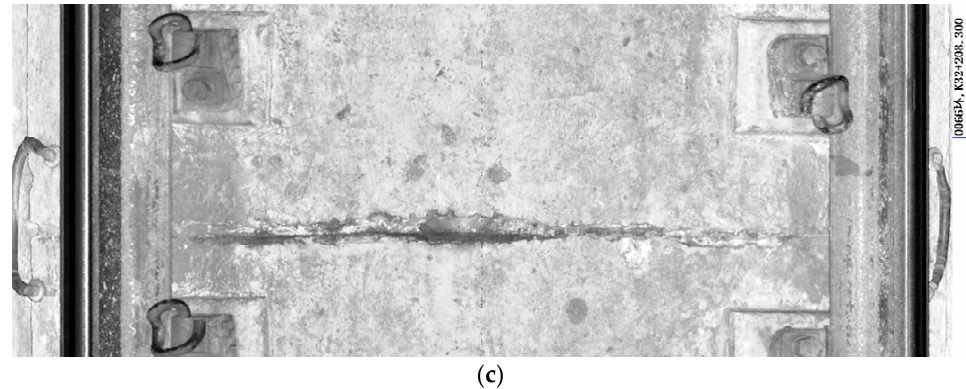
Figure 13. Typical diseases in this scanning section: ( a ) water leakage, ( b ) crack between the segment and monolithic track bed, and ( c ) dislocation and damage of a ballast settlement joint (example).